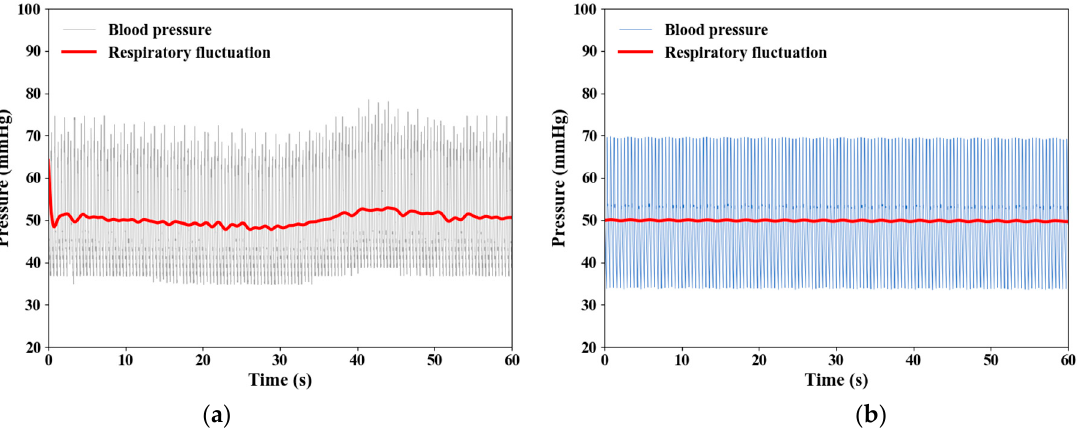
Figure 5. Comparison of RF waveforms between ( a ) clinical measurements and ( b ) 0-1D hemody- namic model-based simulations (subject: 1-year-old, ASD).